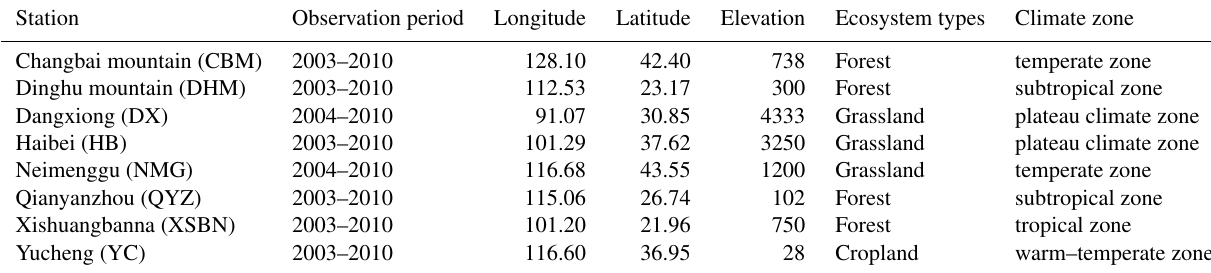
Table 1. Details of the eight flux observation stations. Station Observation period Longitude Latitude Elevation Ecosystem types Climate